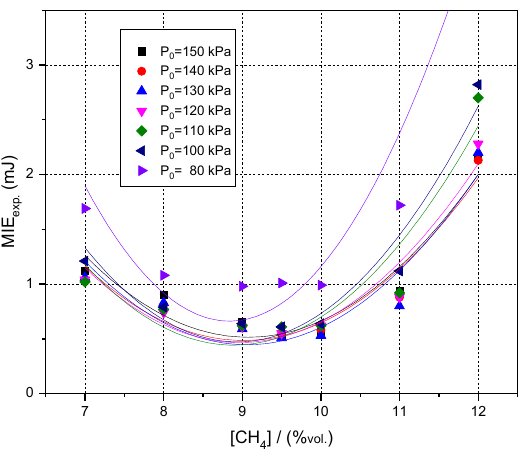
Figure 6. The variation of minimum ignition energy for CH 4 –air mixtures at different initial pressures and methane concentrations.